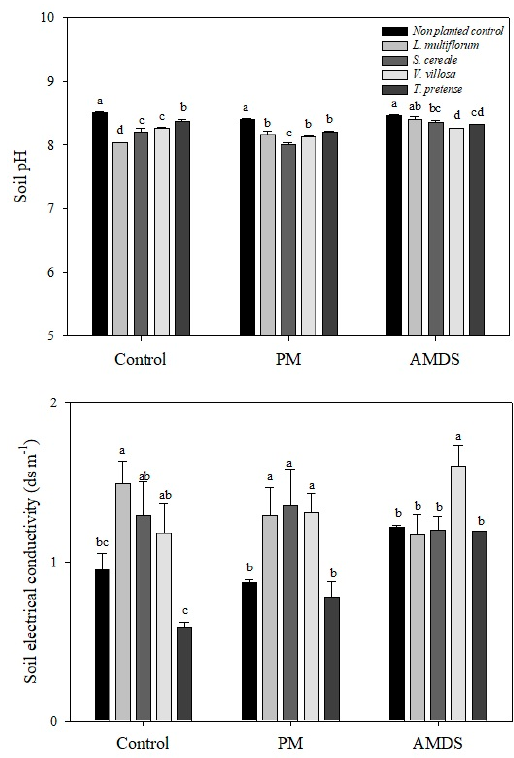
Figure 1. Changes in soil pH and electrical conductivity with different types of amendments treatments and plant species ( Loliummultiflorum and Secalecereale (Poaceae family representatives) and Trifoliumpratense and Viciavillosa (Leguminosaefamily representatives)). Different letters indicate significant differences among the NPC (nonplanted control) and the four plant species with same treatment, using Tukey’s test Error bars represent ± standard deviation of three replicates ( n = 3). Cultivation of all four plant species significantly decreased the pH of the alkaline soil, e.g., from 8.51 to 8.04, 8.21, 8.27, and 8.37 for L. multiflorum , S. cereale , V. villosa , and T. pretense , respectively, and